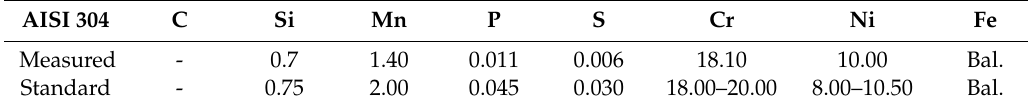
Table 1. Chemical composition of the alloy, compared with standard values (in wt%).